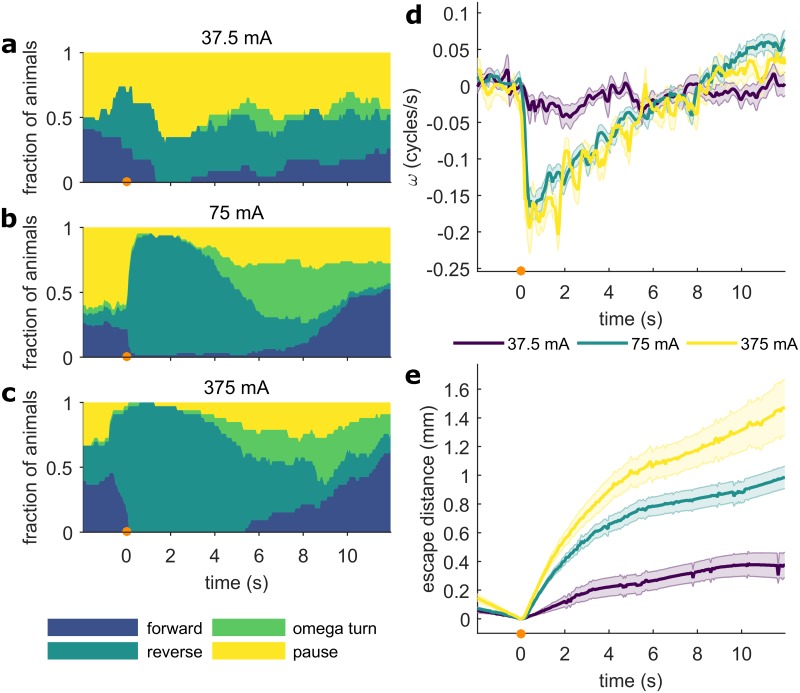
The probability and magnitude of the C. elegans escape response depends on the amplitude of the thermal stimulus.Responses to three levels of thermal stimuli are shown (all 100 ms, focused by a 75 mm lens). Plots are aligned so that the stimulus is at t = 0 s (indicated by an orange circle). (a-c) Fraction of animals in each of the four behavioral states, for three different laser power levels: (a) 37.5 mA (n ≥ 23), (b) 75 mA (n ≥ 65), and (c) 375 mA (n ≥ 33). 75 mA is the primary power level used in this work because it elicits robust responses from most animals, but does not fully saturate the response. (d) Population average phase velocity for each power level. Shaded regions indicate the standard error of the mean. (e) Mean escape distance. Shaded regions indicate the standard error of the mean. Full ethograms shown in S2 Fig.